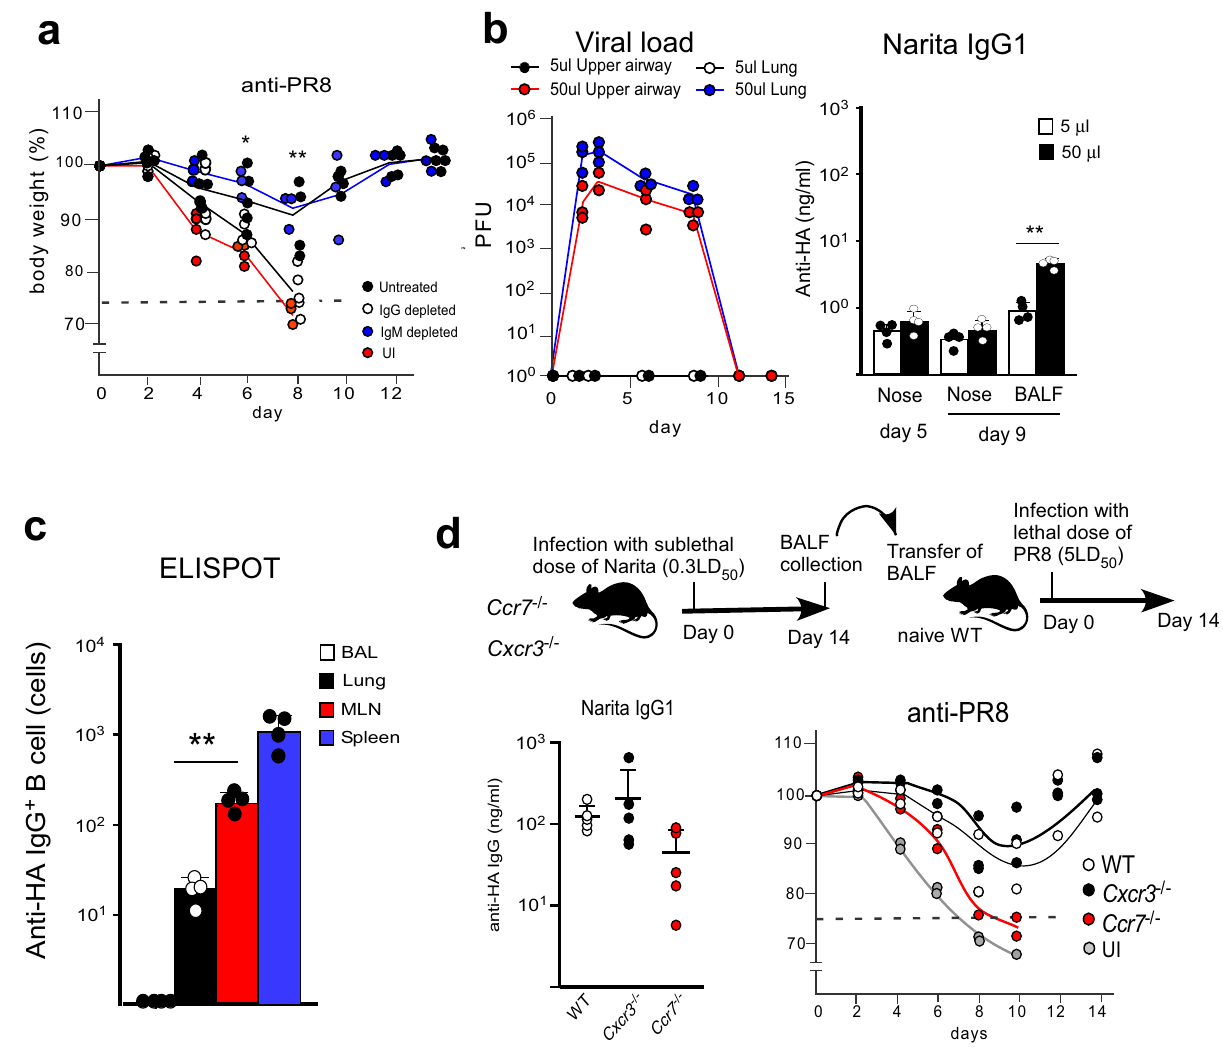
Fig. 2 Anti-HA IgG responses in MLN are associated with broad in fl uenza virus protection. a Mice intranasally transferred with untreated (black dots; n = 5), IgG-depleted (white dots; n = 6), or IgM-depleted (blue dots; n = 3) BALF from A/Narita/1/2009 infected mice were challenged intranasally with a lethal dose of A/PR/8/1934. The data indicate body weight change of uninfected mice (red dots; UI n = 3) and the transferred mice with BALF. Missing symbols mean that the mice were euthanized, as described in Fig. 1b. b Kinetics of viral load (PFU) in the upper airway (black and red dots) and deeper lung (white and blue dots) were examined in mice infected with 5 or 50 μ l of A/Narita/1/2009 suspension (left n = 3 for each). The titer of A/H1N1pdm09 HA- speci fi c IgG1 in the nasal wash and BALF at day 5 and day 9 were determined by ELISA (right, white bars and black bars for 5 and 50 μ l, respectively; n = 4 for each). c Numbers of A/Narita/1/2009-HA-speci fi c IgG producing B cells in BALF (white), lung (black), MLN (red), or spleen (blue) from infected mice at 14 day were determined by ELISPOT ( n = 4 for each). d IgG1 antibody titers speci fi c for or A/Narita/1/2009-HA in BALF from WT (white), Ccr7 − / − (red), or Cxcr3 − / − (black) ( n = 5 for each) mice were measured at day 14 post-infection with A/Narita/1/2009 (left). Top panel indicates the design of the BALF transfer experiment for protective antibodies in Ccr7 - or Cxcr3 -de fi cient mice. Mice intranasally administered with BALF from WT, Ccr7 − / − or Cxcr3 − / − mice infected with A/Narita/1/2009 (WT n = 2, Ccr7 − / − n = 2, Cxcr3 − / − n = 3) were challenged intranasally with a lethal dose of A/PR/8/ 1934. The body weight change of mice was monitored until 14 days post-infection. Missing symbols mean that the mice were euthanized, as described in Fig. 1b. UI represents unimmunized. Bars represent mean; * p < 0.05, ** p < 0.01 by unpaired, two-tailed t -test (Untreated group with IgG depleted group in a , 5 µ l group with 50 µ l group in b , Lung group with MLN group in c ). All error bars represent